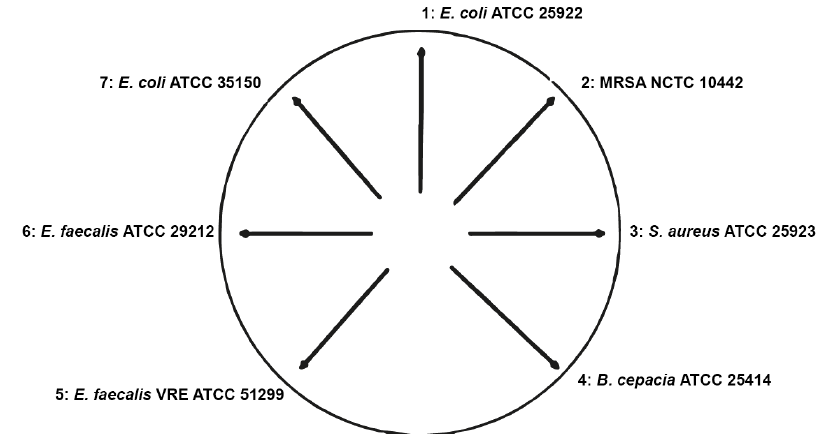
Figure 3. Schematic representation of the cartwheel method. Three strains of gram-negative bacteria (1, 4, 7) and four strains of gram-positive bacteria (2, 3, 5, 6) were streaked on EtBr-agar plates and incubated overnight.